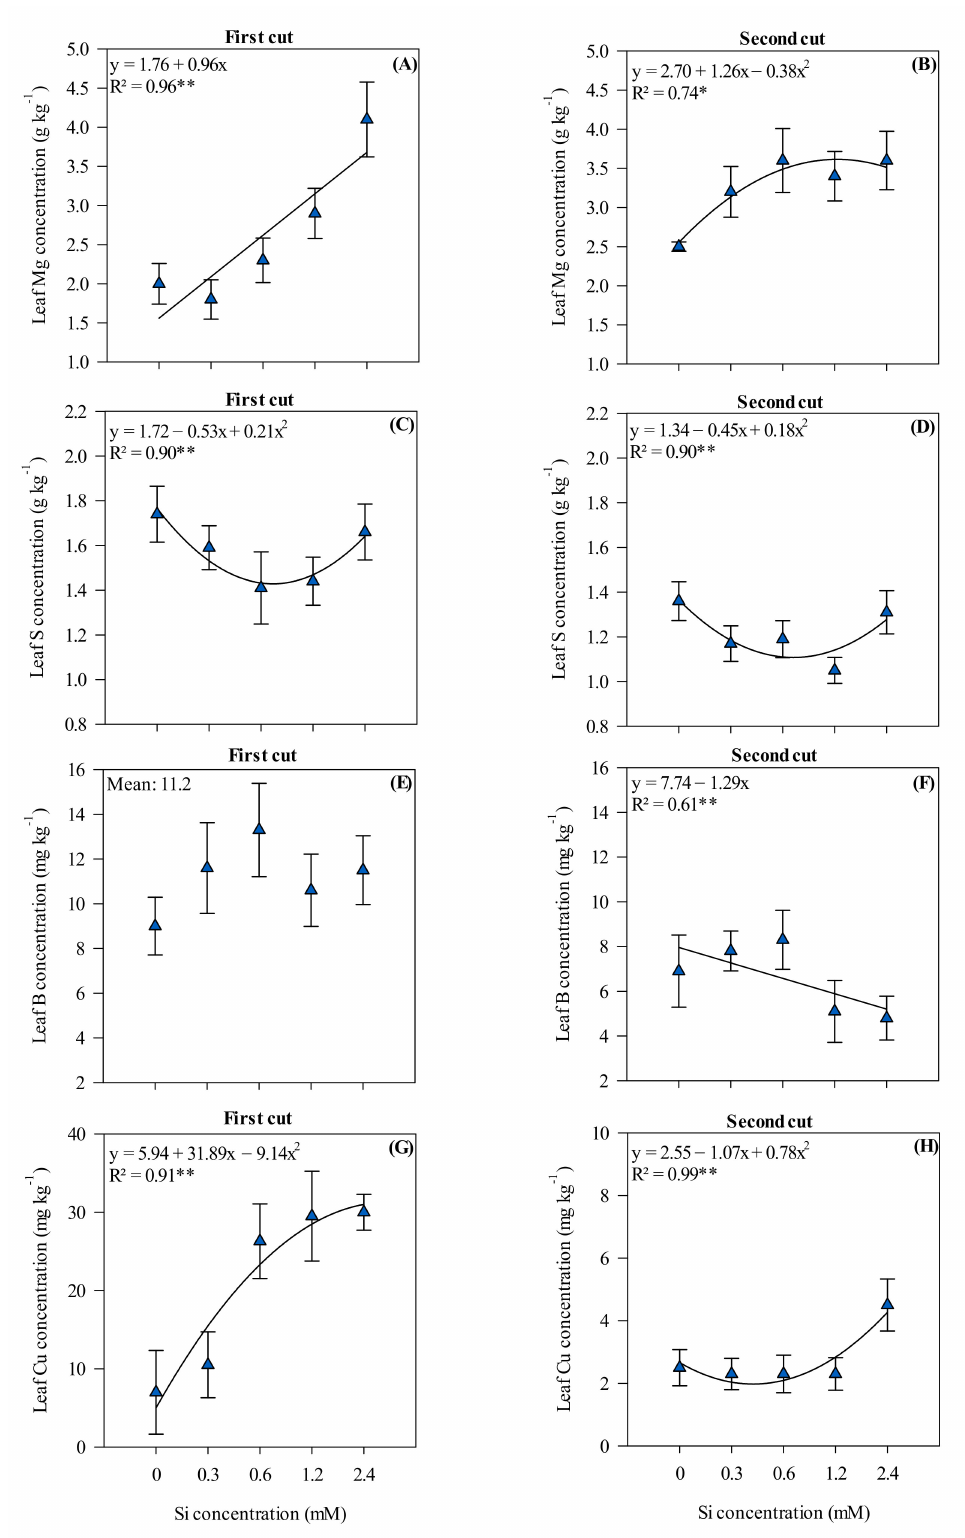
Figure 5. Leaf Mg concentration in the first ( A ) and second cut ( B ), leaf S concentration in the first ( C ) and second cut ( D ), leaf B concentration in the first ( E ) and second cut ( F ), leaf Cu concentration in the first ( G ) and second cut ( H ) as a function of increasing Si concentrations in Xara é s palisadegrass. Error bars indicate the standard deviation of the mean ( n = 4). * and ** = significant at 5 and 1% probability by F test